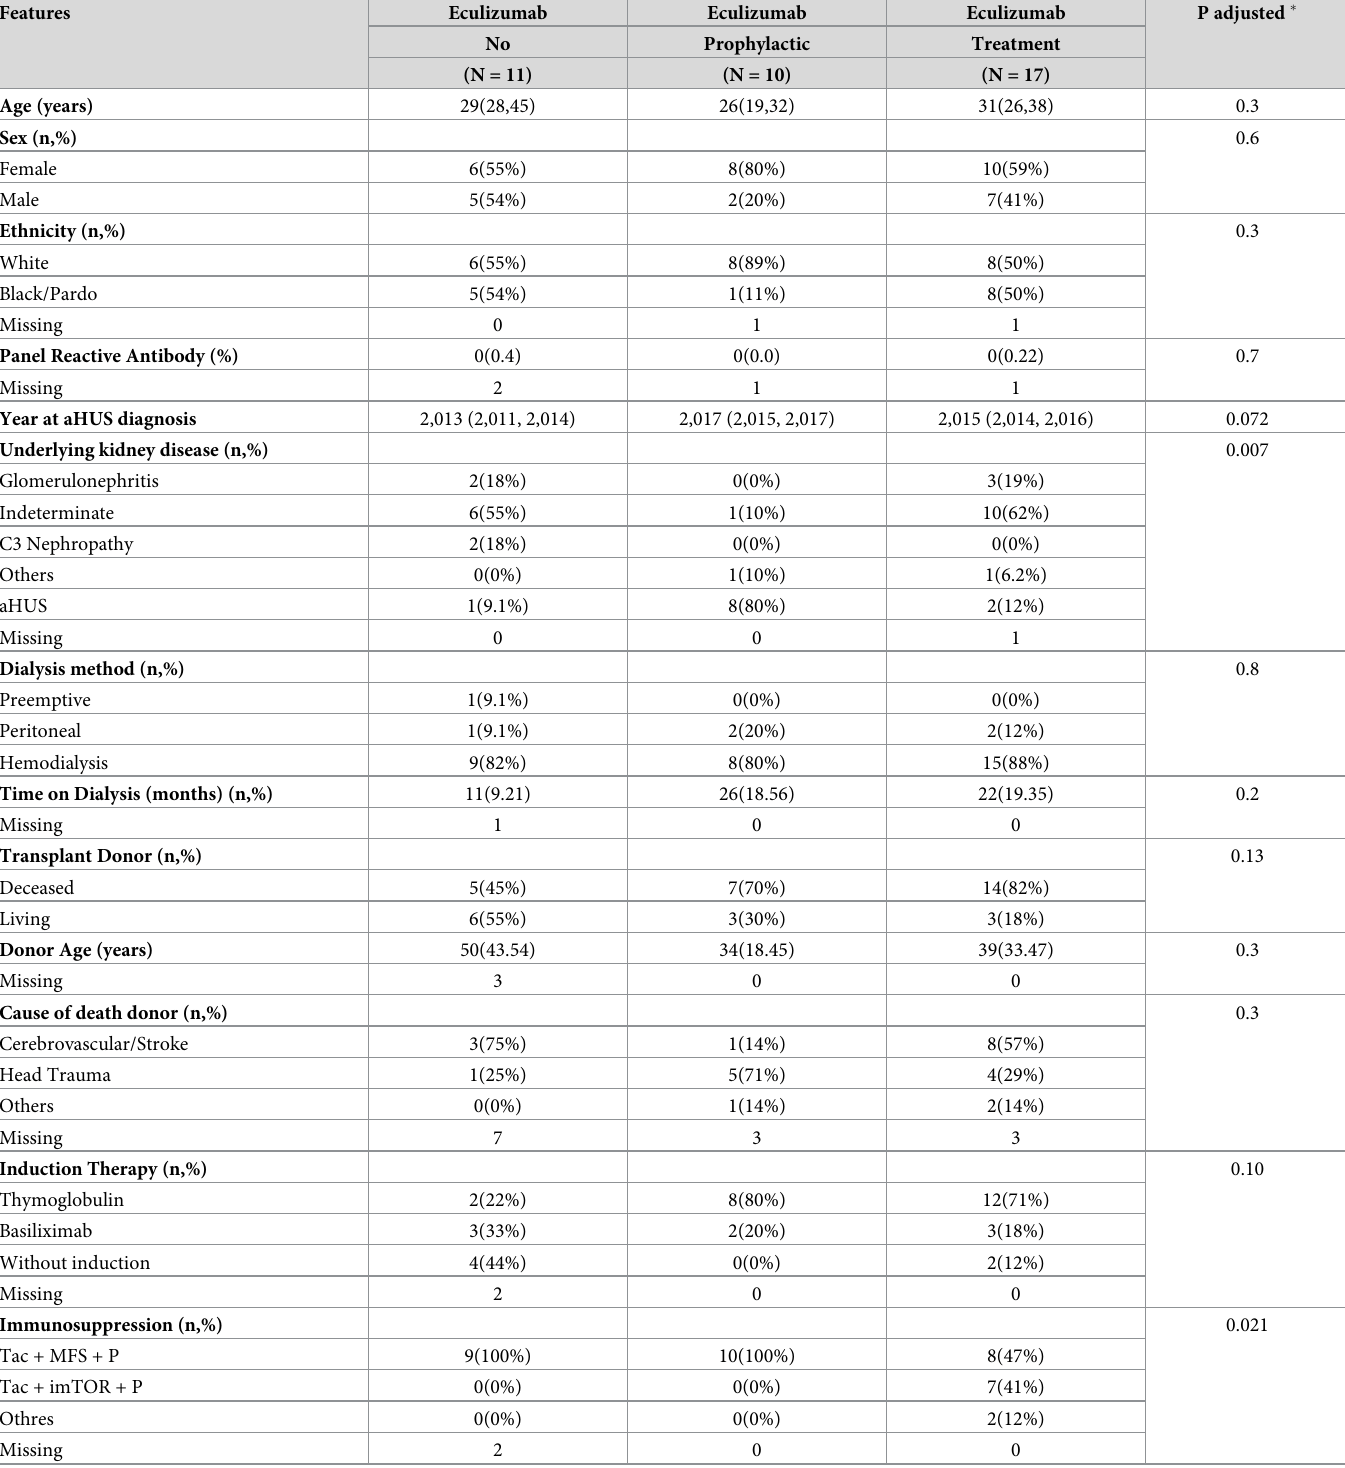
Table 3. Comparison of demographic and outcome in the Brazilian aHUS cohort patients according to the treatment (without the use of Eculizumab, prophylactic Eculizumab, and Eculizumab